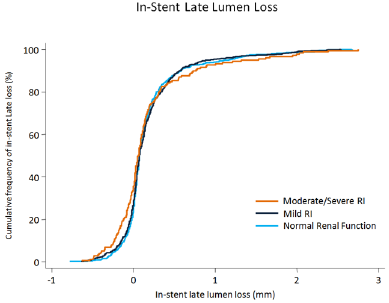
Figure 2. Angiographic Effectiveness. Cumulative frequency of in- stent late lumen loss at the time of follow-up angiography according to baseline renal function. RI=Renal impairment.